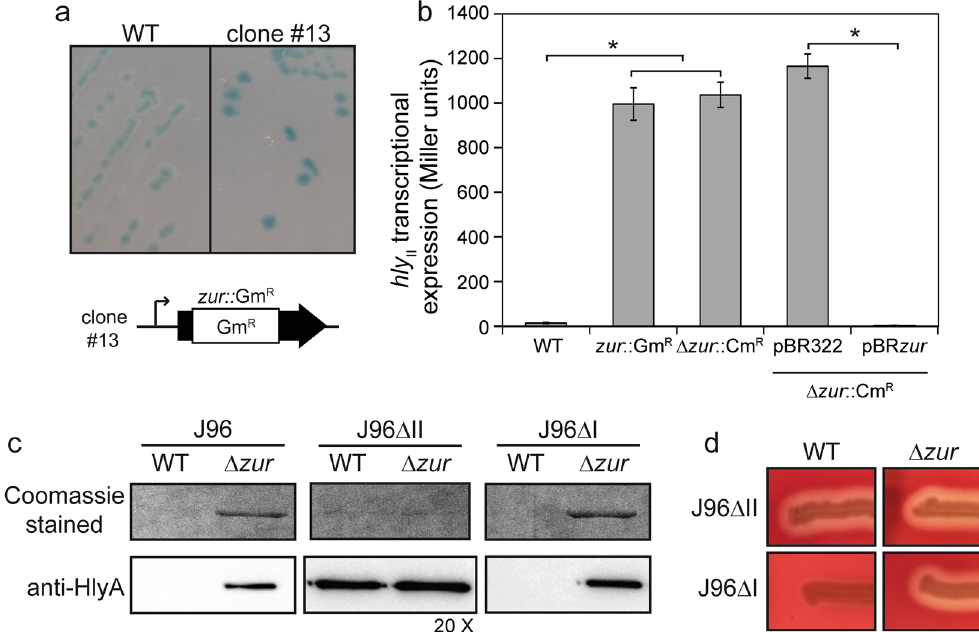
Figure 2. Expression of the hly II operon of J96 is derepressed by a mutation in the zur gene. ( a ) Lac-phenotype on LB Xgal agar plates of the JFV3 (J96 hly II :: lacZ ) strain and its Gm R derivative (clone #13) obtained by random mutagenesis. Below is represented the location of the Gm R transposon insertion in clone #13. ( b ) Transcriptional expression of the hly II operon from cultures of the JFV3 strain and the two derivatives zur:: Gm R (clone #13) and zur:: Cm R (EV46) grown in LB at 37 °C up to late-log phase (OD 600 nm of 1.0). β -Galactosidase activity (Miller units) was determined in three independent cultures. Mean values with standard deviations are plotted. * P < 0.05, ANOVA with Tukey’s multiple comparisons test. ( c ) Electrophoretic analysis of secreted protein extracts from cultures grown in LB at 37 °C up to late-log phase of J96, JFV16 (J96 Δ II) and JFV21 (J96 Δ I) strains and their otherwise isogenic zur:: Cm R mutants (EV27, EV34 and EV38, respectively). Upper panels are Coomassie blue stained 10% SDS-PAGE and lower panels immunodetection using monoclonal anti-HlyA antibody. Samples for immunodetection from J96 Δ II were concentrated 20x with respect to rest of samples for better visualization. Full-length gel and blot images are shown in Fig. S7. ( d ) Hemolytic phenotype of JFV16 (J96 Δ II) and JFV21 (J96 Δ I) strains and its zur mutant derivatives on Columbia Blood agar